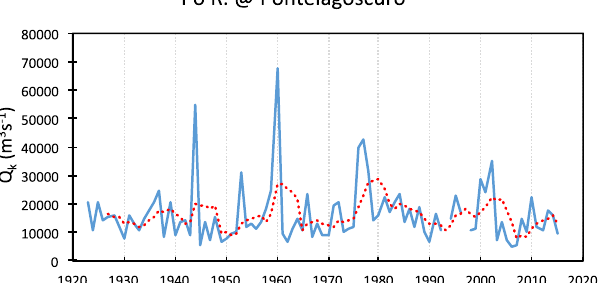
Figure 3. Sediment transport capability, effective discharge ( Q k ) time series. It shows that in the last 50 years only three periods of potential high sediment flux occurred around 1960, 1976–1977 and 2000–2002. The interval between the last two peaks, 26 years, is the largest of the time series and coincides with the phase of higher retreat rates of the delta. The red dotted line is the five-years moving average.